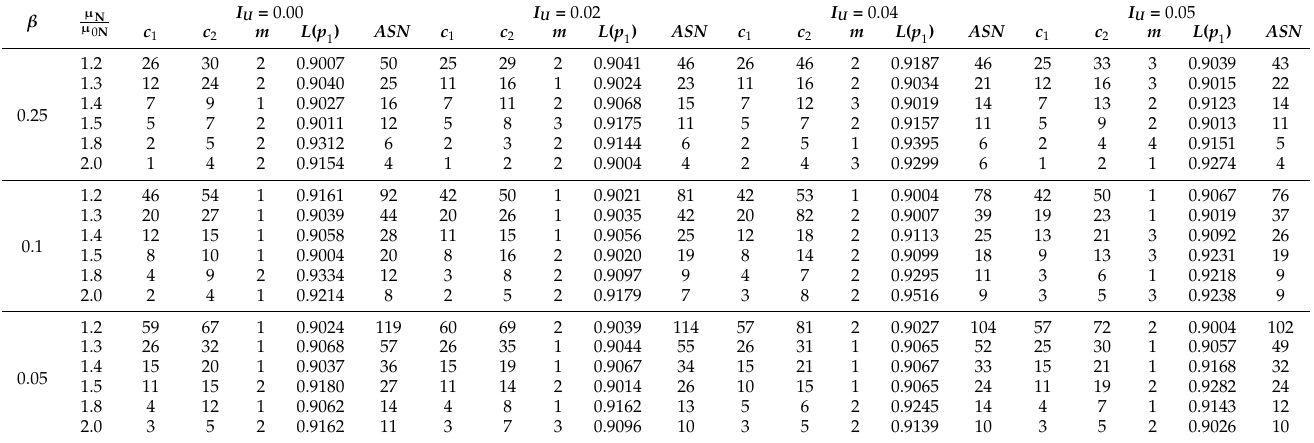
Table 4. The MDS design values for α = 0.10, ν = 2.5, and a = 1.00.